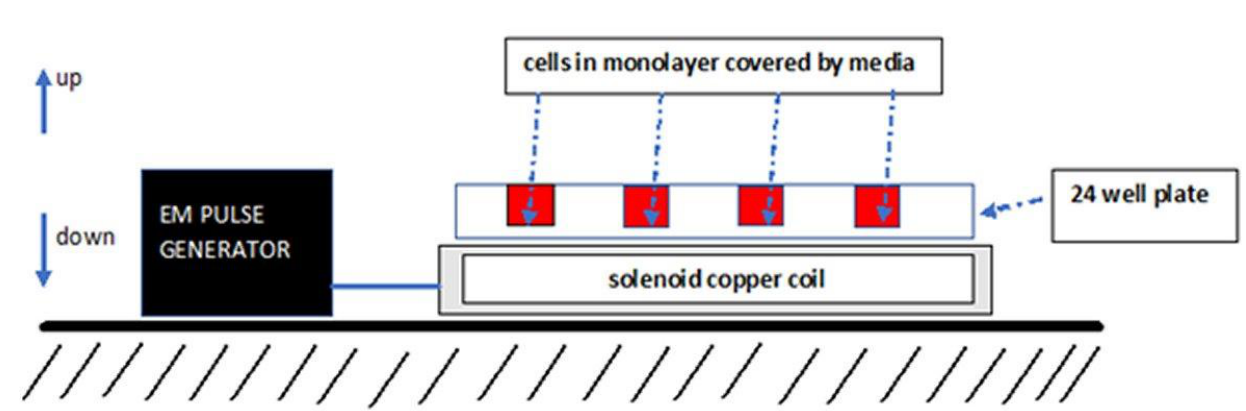
Figure 1 : Simplistic schematic representation of the tunable experimental setup for the exposure of cultured osteoblast-like cells to an alternating pulsed electromagnetic field (AEMF) and pulsed electromagnetic field (PEMF). EM: Electromagnetic